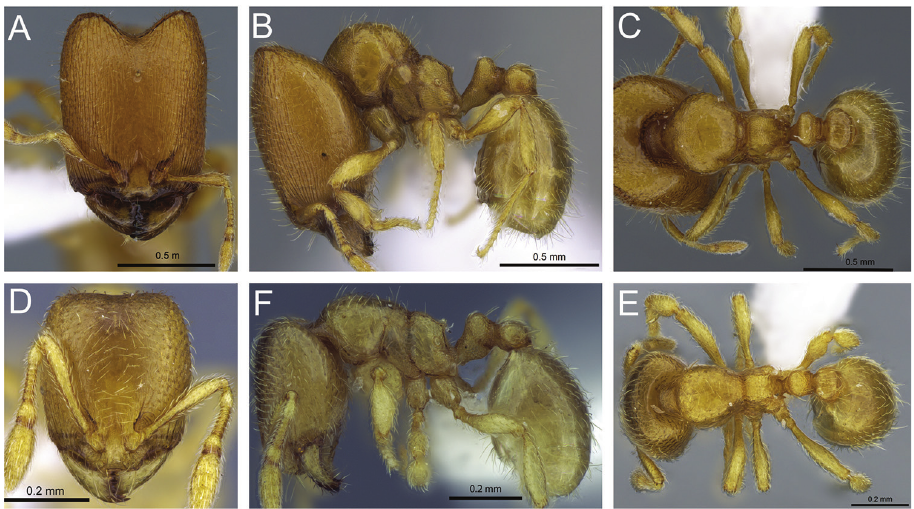
Figure 45. Carebara kabosy –holotype. Major worker, CASENT0438062: A head in full-face view B body in profile view C body in dorsal view. Minor worker: CASENT0437739 D head in full-face view E body in profile view F body in dorsal